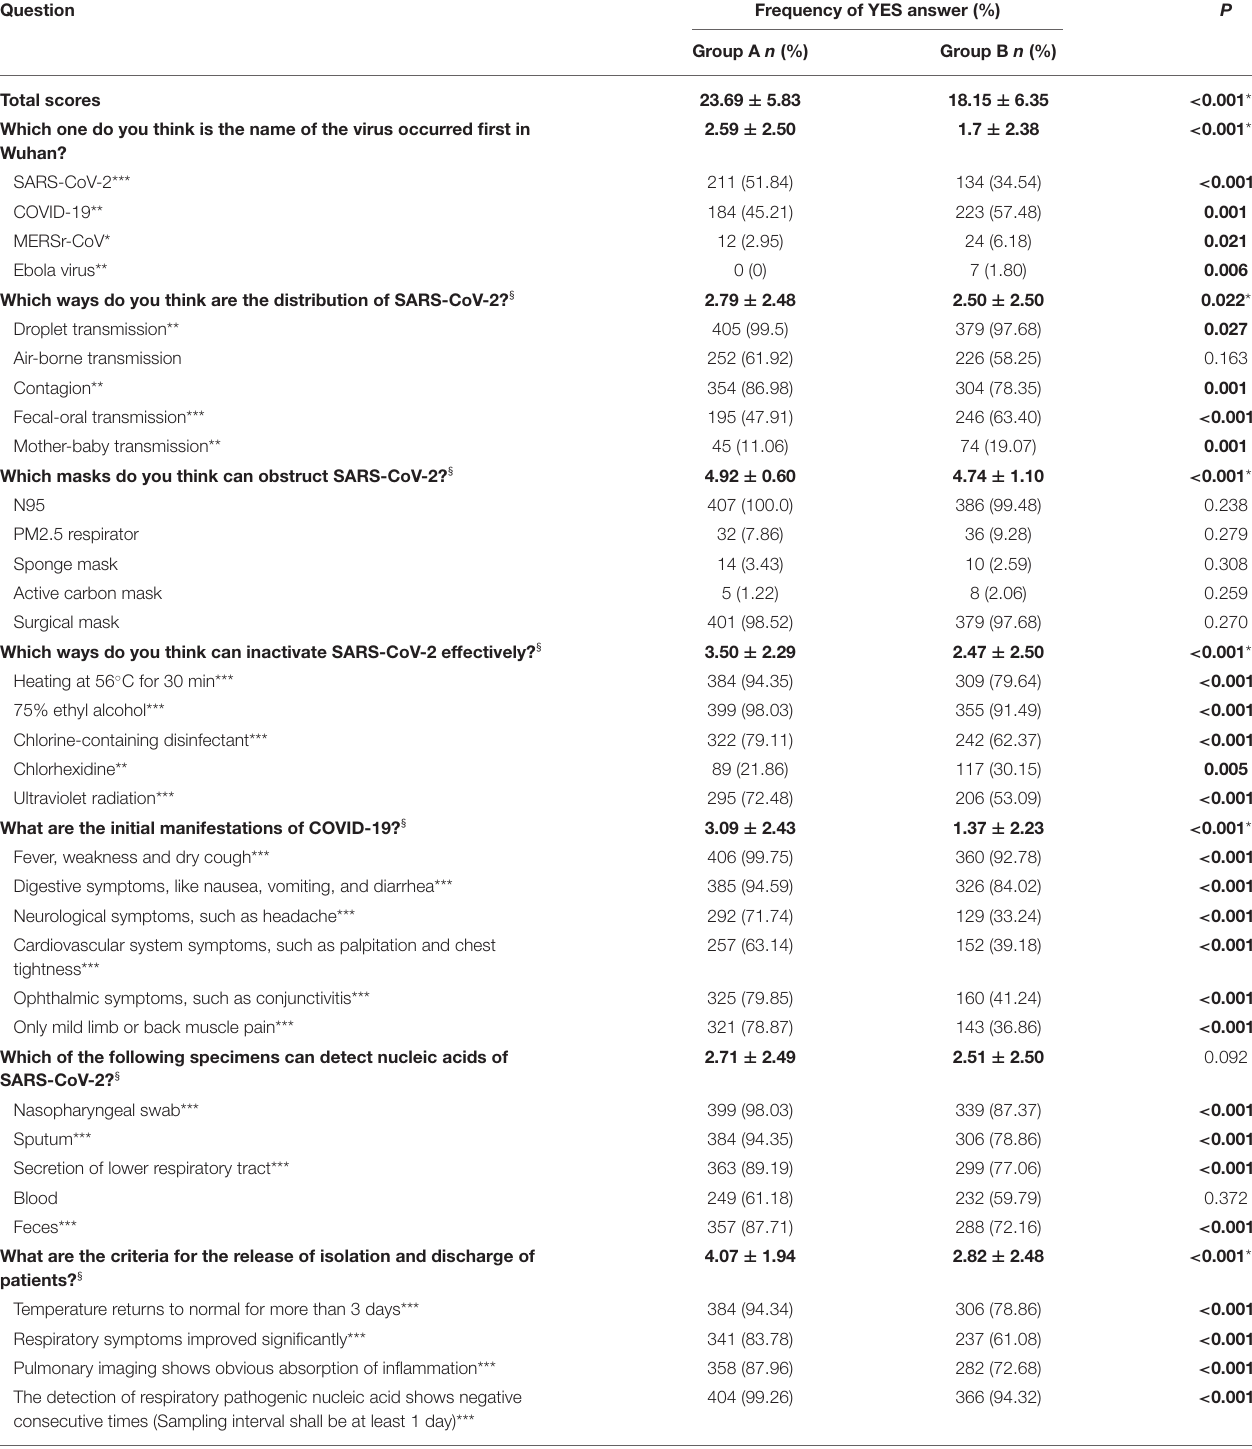
TABLE 2 | Knowledge related to COVID-19 including epidemiology and clinical